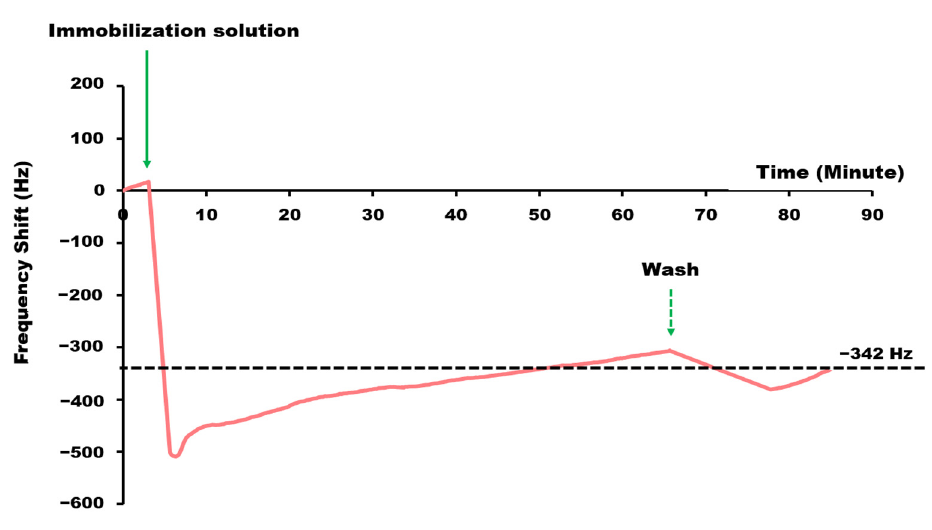
Figure 1. QCM resonant frequency shift upon immobilization of thiolated-ssDNA probe with L-cysteine on the QCM electrode.